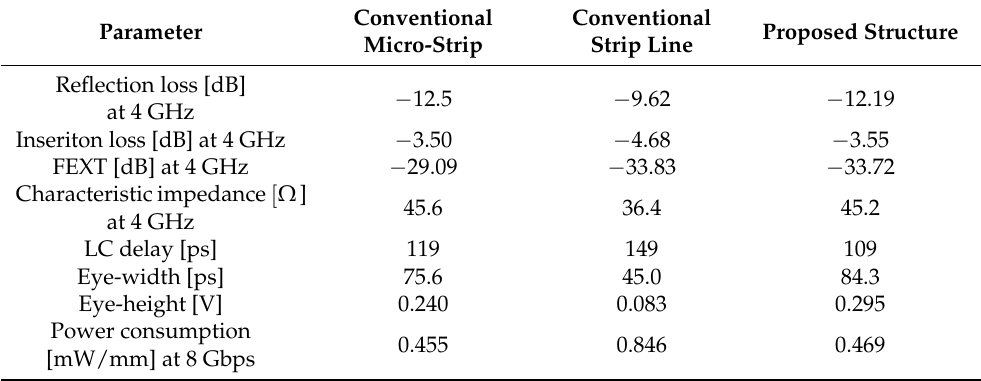
Table 3. Summary of system performance of the proposed and conventional